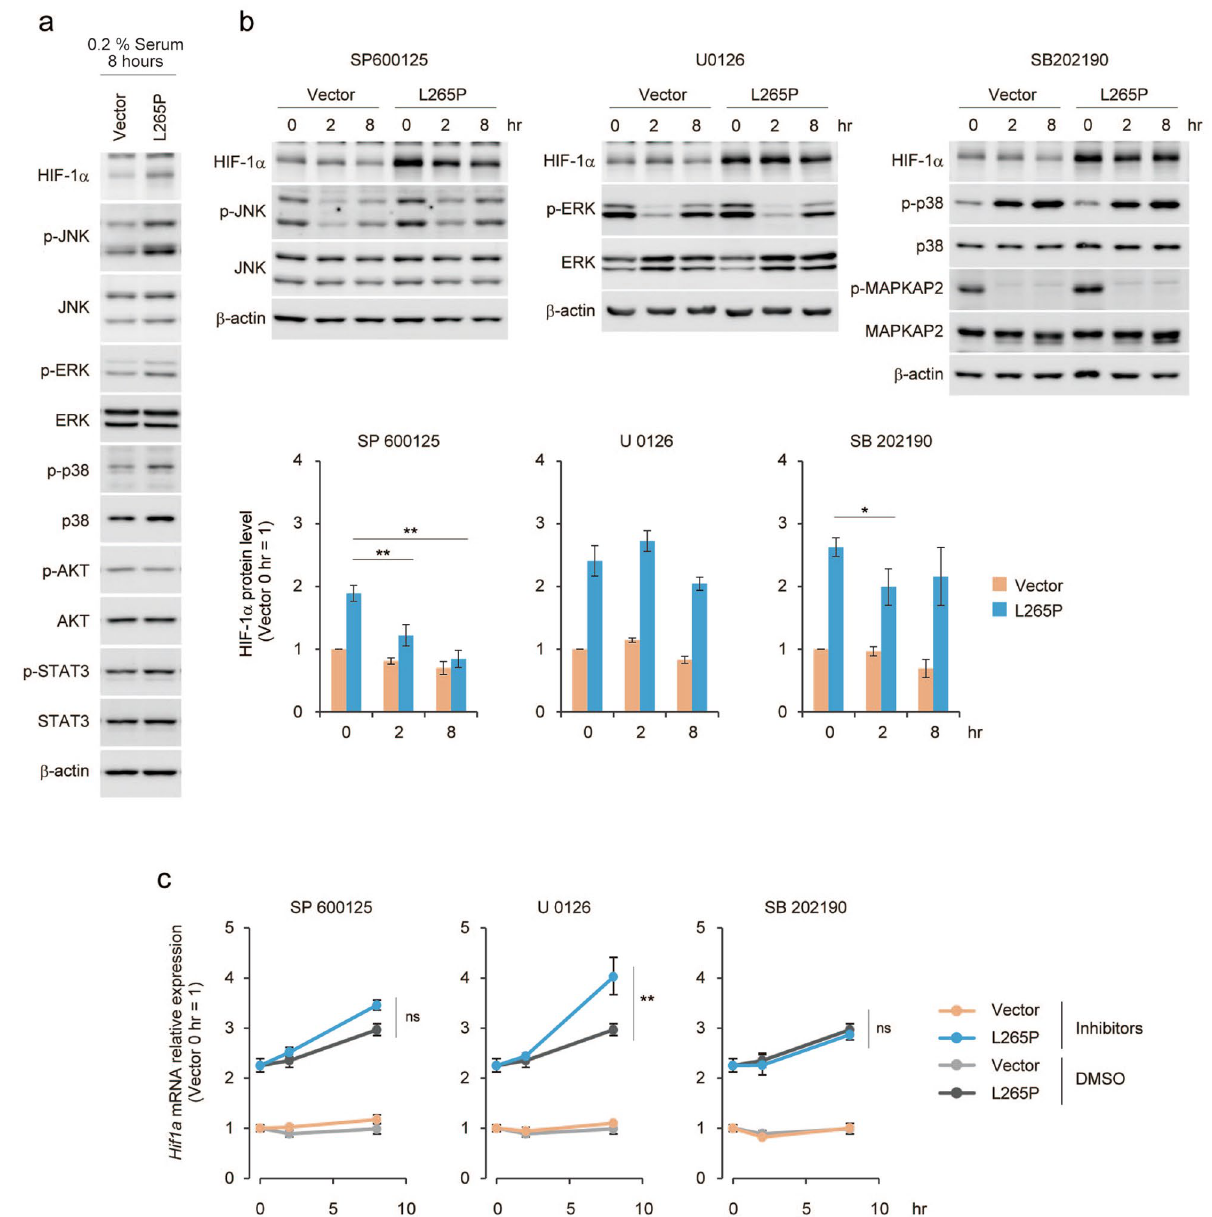
Figure 5. JNK signalling is associated with HIF-1α protein level in MYD88 L265P-expressing p53 −/− MEFs. ( a ) Vector and MYD88 L265P-expressing p53 −/− MEFs were treated with growth medium containing 0.2% FBS for 8 h. ( b ) Vector and MYD88 L265P-expressing p53 −/− MEFs were treated with the indicated MAPK inhibitors. Total cell lysates were analysed by immunoblotting (top). The quantification of HIF-1α signals was measured using ImageJ software and data were normalised to β-actin signals. The data represent untreated controls (vector), which were assigned a value of 1 (bottom). ( c ) Hif1a mRNA expression was measured by qPCR. The y-axis values are the relative fold change for gene transcripts. Each value was normalised to β-actin. ( b , c ) The data represent the mean ± s.d. using one-way ANOVA followed by Scheffe’s F test. *P < 0.05, **P <